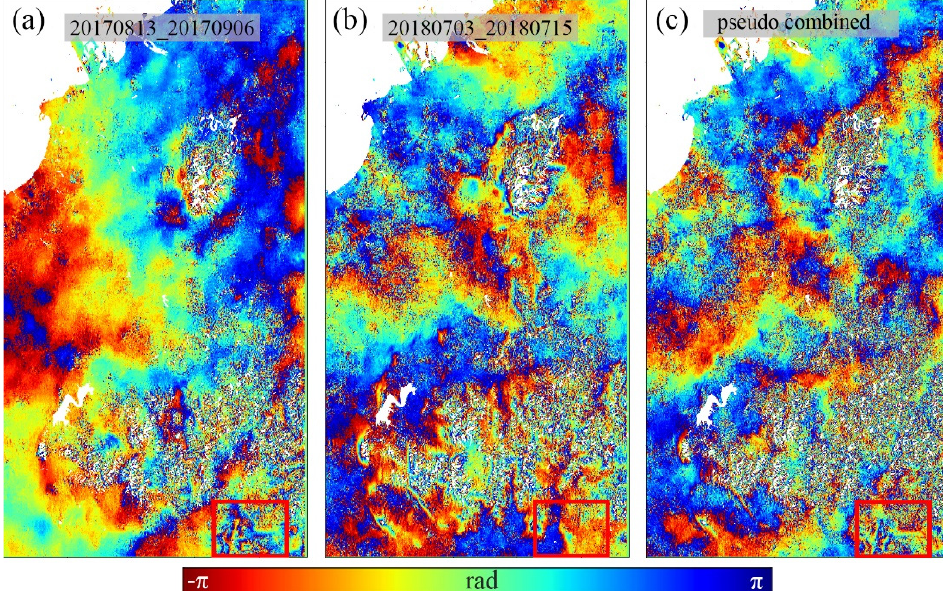
Figure 16. Example of noise propagation. ( a , b ) The two original interferograms with different time spans and ( c ) the pseudo-combined interferogram of the previous two images. The red rectangle shows the typical noise propagation phenomenon.